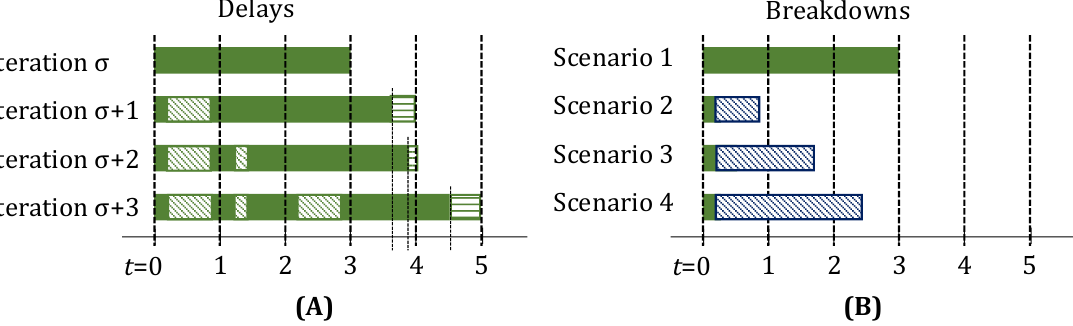
Figure 7. The task has a nominal processing time τ = 3. Time-grid spacing is δ = 1 h. Here, for ease of discussion, the time-grid is global, i.e., it is not reset for each iteration. ( A ) A delay (shown as oblique green pattern) of 0.66 h in time-period (0, 1) is observed. Since, (cid:100) 0.66 (cid:101) = 1, a delay of 1 h is applied at t = 1. This would ensure that the task finish is aligned with t = 4, even if the task actually ends at t = 3.66. The horizontal green pattern represents the fictitious extra task runtime to align with the discrete time-grid. Next, another delay of 0.2 h is observed in time-period (1, 2). Since, (cid:100) 0.66 + 0.2 (cid:101) − (cid:100) 0.66 (cid:101) = 0, no additional delay is applied in the update steps. This makes sense, because, the task finishes at t = 3.86 in reality. Since, the previous delay was applied as 1 h, the task is now still thought to finish at t = 4, in alignment with the time-grid. Finally, when another delay of 0.66 h is observed in time-period (2, 3). Since, (cid:100) 0.66 + 0.2 + 0.66 (cid:101) − (cid:100) 0.66 + 0.2 (cid:101) = 1, a 1 h delay is applied in the update step. This correctly ensures that the task is now thought to end at t = 5, which is the round up of the true end time of t = 4.52 h. ( B ) A break-down is observed at t = 0.2. Thus, ˙ Z 0 = 1 for the update step between the iterations starting at t = 0 and t = 1. If the downtime (blue) is 0.66 h, then the unit actually becomes available at t = 0.86. Thus, ˆ Λ ( t = 1 ) is not activated. This is indeed the case from our mathematical procedure as well, since, t ∈ ( 0.2,0.86 ] does not include any